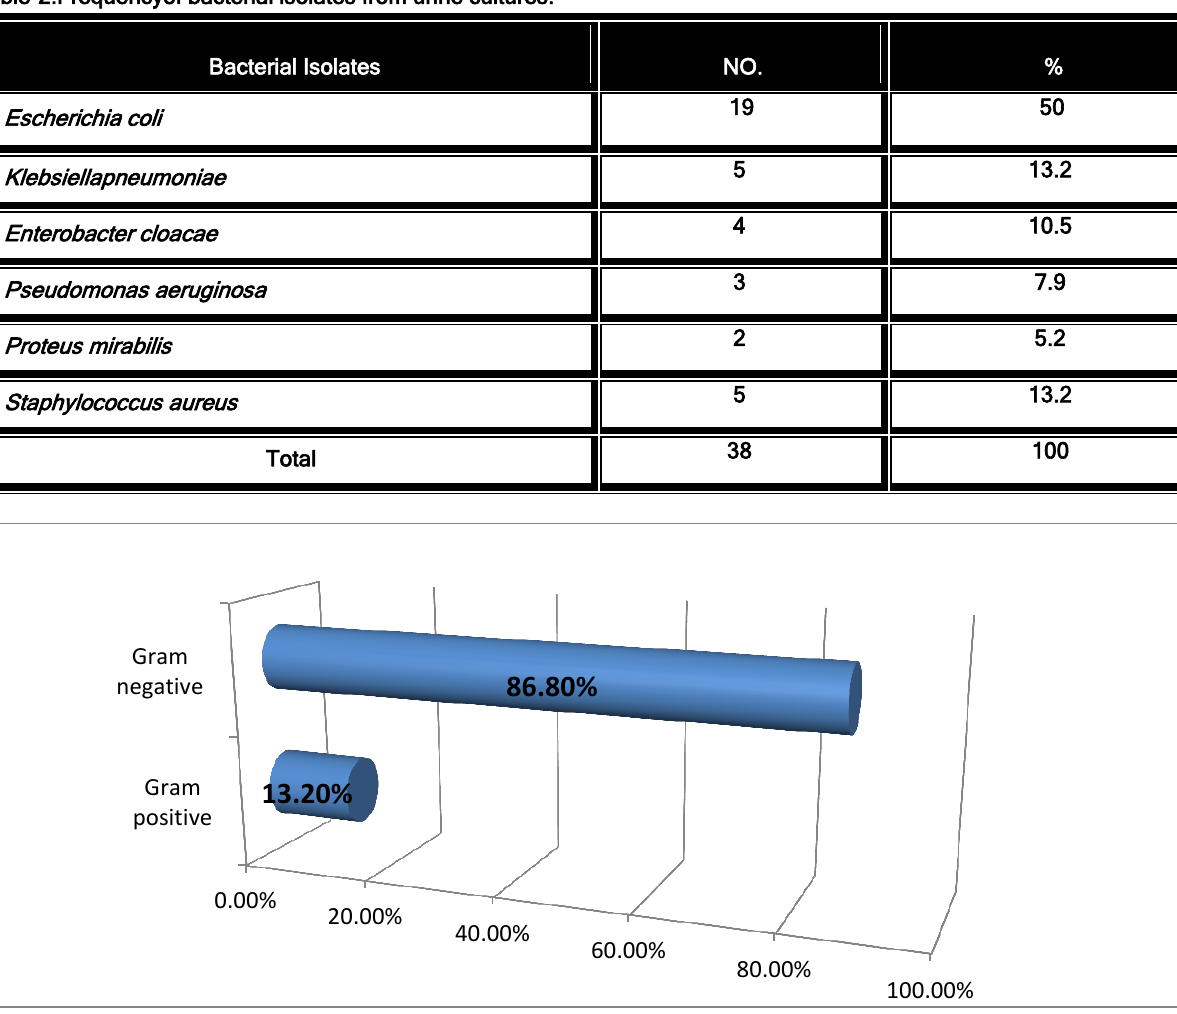
Table-2:Frequencyof bacterial isolates from urine cultures.